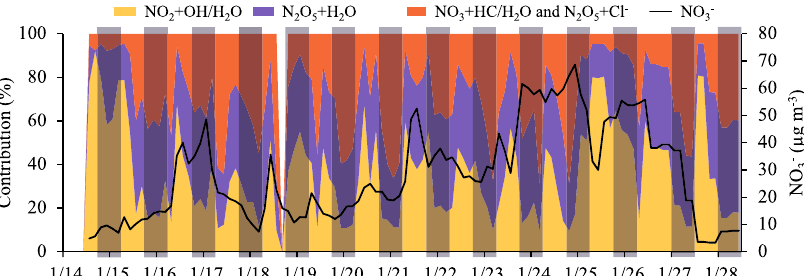
Fig. 3 Nitrate formation pathways during the haze event. Time series of mass concentrations of nitrate ( NO (cid:1) contributions of three pathways (pathway 1: the reactions of nitrogen dioxide with hydroxyl radical and liquid water (NO 2 + OH/H 2 O), pathway 2: the hydrolysis of nitrogen pentoxide (N 2 O 5 + H 2 O) and pathway 3: the reactions of nitrate radical with hydrocarbon and liquid water as well as the reaction of nitrogen pentoxide with chloridion on particle surface (NO 3 + HC/H 2 O and N 2 O 5 + Cl − )) to nitrate production during the haze event from January 14th to January 28th, 2015. The contribution fractions are estimated by the Bayesian model. The gray shades represent the night.